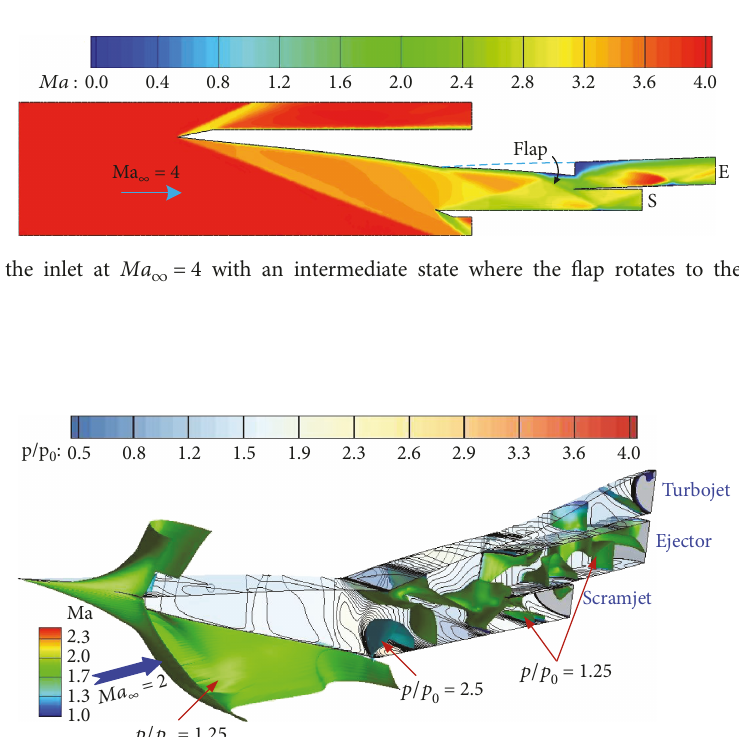
Figure 10: Flow contour of the inlet at Ma respectively, p / p 0 = 1 25 and 2.5, are contoured by the Mach number.